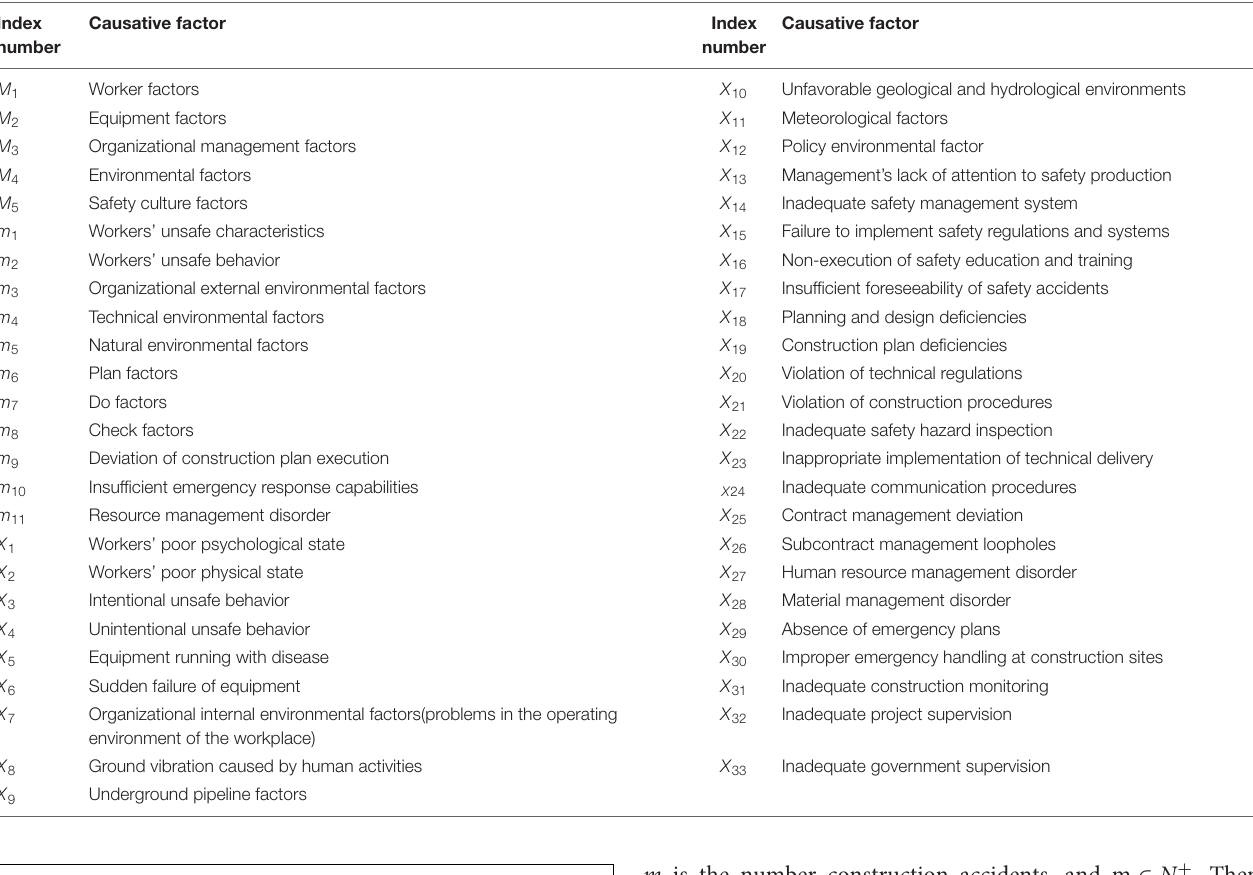
TABLE 3 | Subway construction accident causation index explanation.